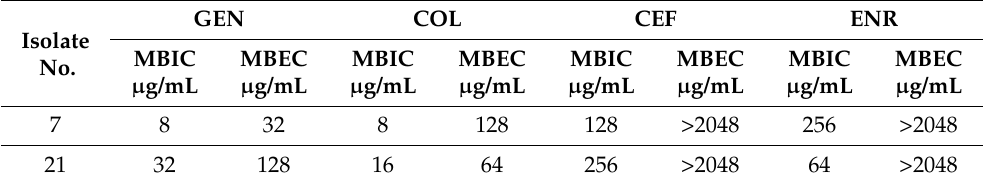
Table 4. Analysis of * MBIC/MRC and MBEC of selected antibiotics on bacterial biofilms.